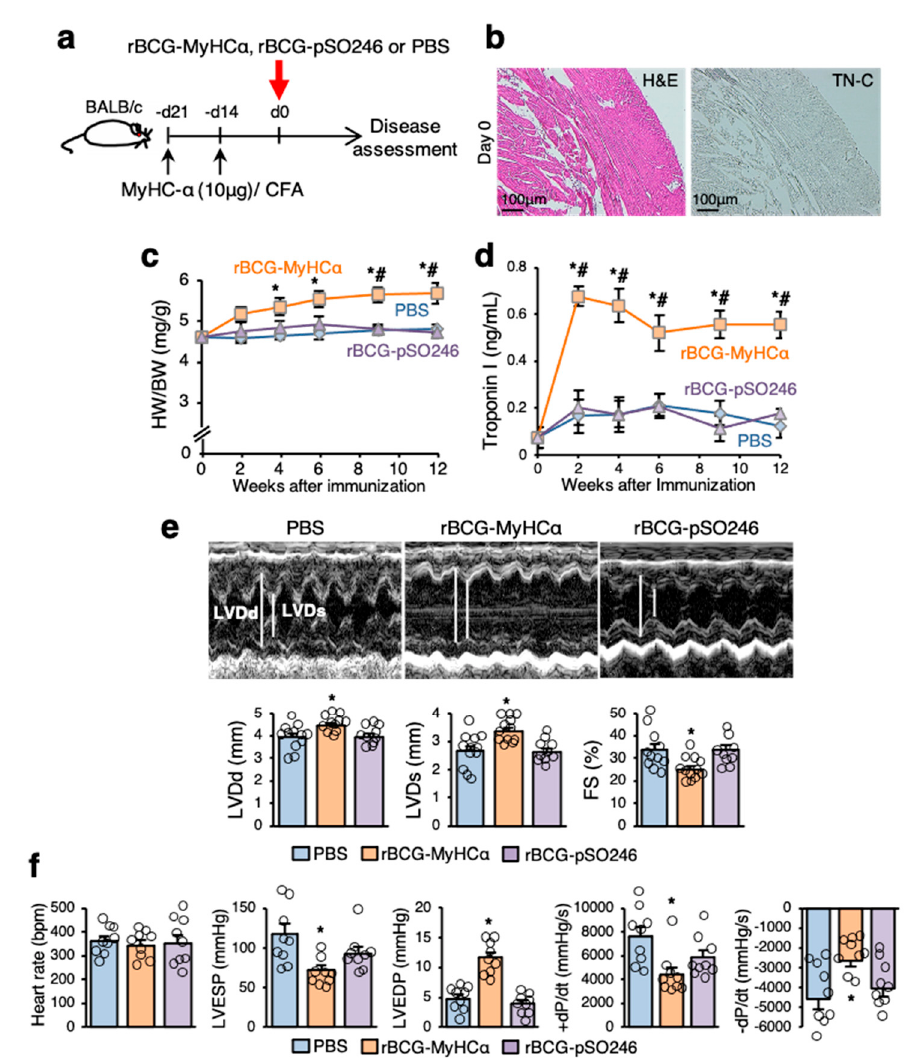
Figure 3. rBCG-MyHC α immunization induced heart failure in mice. ( a ) Mice were immunized twice with 10 µ g of MyHC α peptide/CFA on days 14 and 21 before rBCG immunization for priming. rBCG-MyHC α , rBCG-pSO246, or PBS were injected subcutaneously on day 0. ( b ) Representative histology (H&E staining and TN-C immunostaining) of the heart sections on day 0 (21 days after first immunization with MyHC α ). ( c , d ) HW/BW ( c ) and serum troponin I concentrations ( d ) at indicated time points are shown ( n = 10 each). Results are presented as mean ± SEM. * p < 0.05 vs. PBS and # p < 0.05 vs. rBCG-pSO246 by one-way ANOVA with Tukey’s post hoc test. ( e ) Representative M mode images of echocardiography 12 weeks after rBCG immunization. Bar graphs represent echocardiographic parameters. Results are presented as mean ± SEM, n = 9–12, * p < 0.05 vs. PBS and rBCG-pSO246 by Kruskal-Wallis analysis with a post hoc Steel-Dwass test. ( f ) Bar graphs represent hemodynamic parameters at 12 weeks after rBCG immunization. Results are presented as mean ± SEM, n = 9 each, * p < 0.05 vs. PBS and rBCG-pSO246 by Kruskal-Wallis analysis with a post hoc Steel-Dwass test.